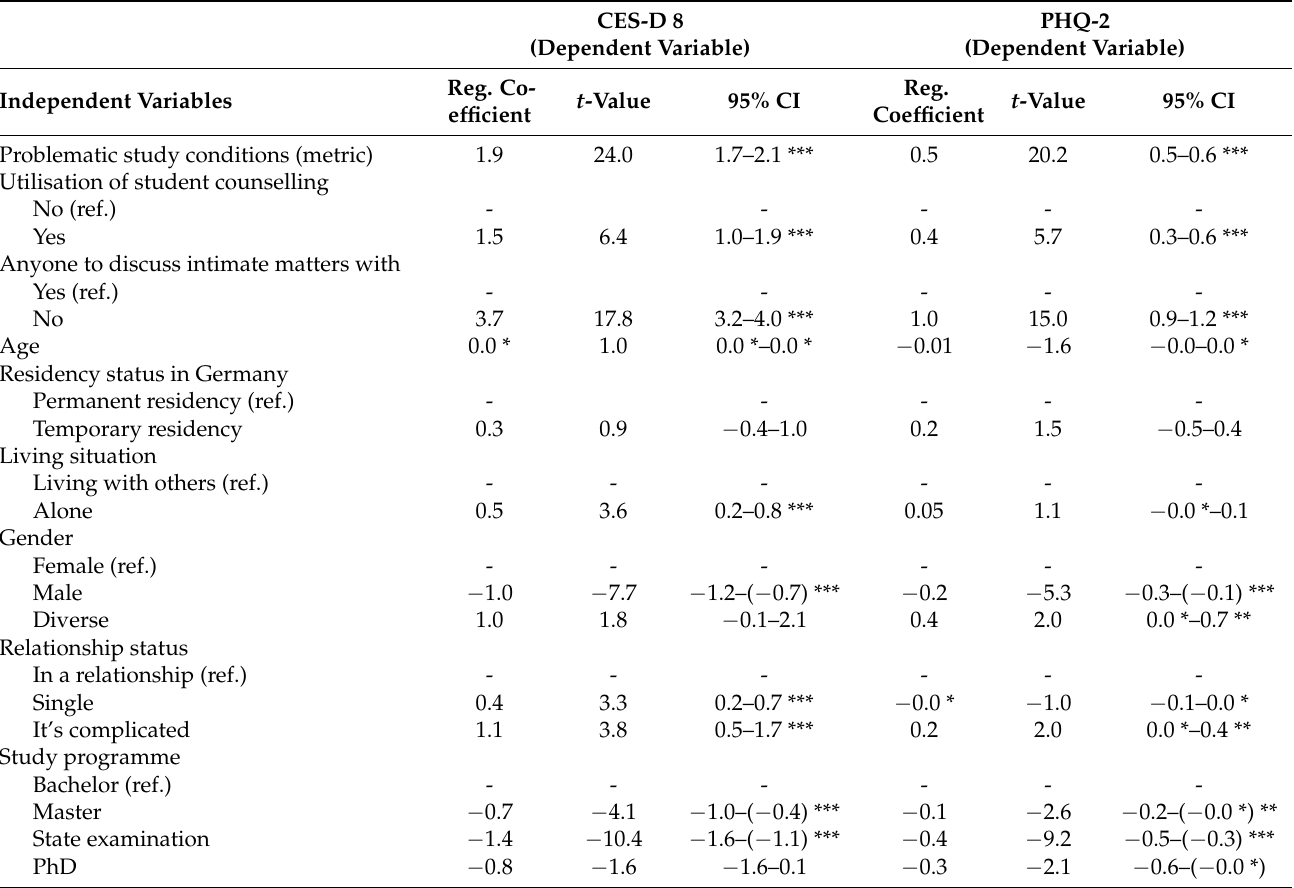
Table 7. Results of two linear regression models to determine the associations between depressive symptoms and study conditions, as well as further